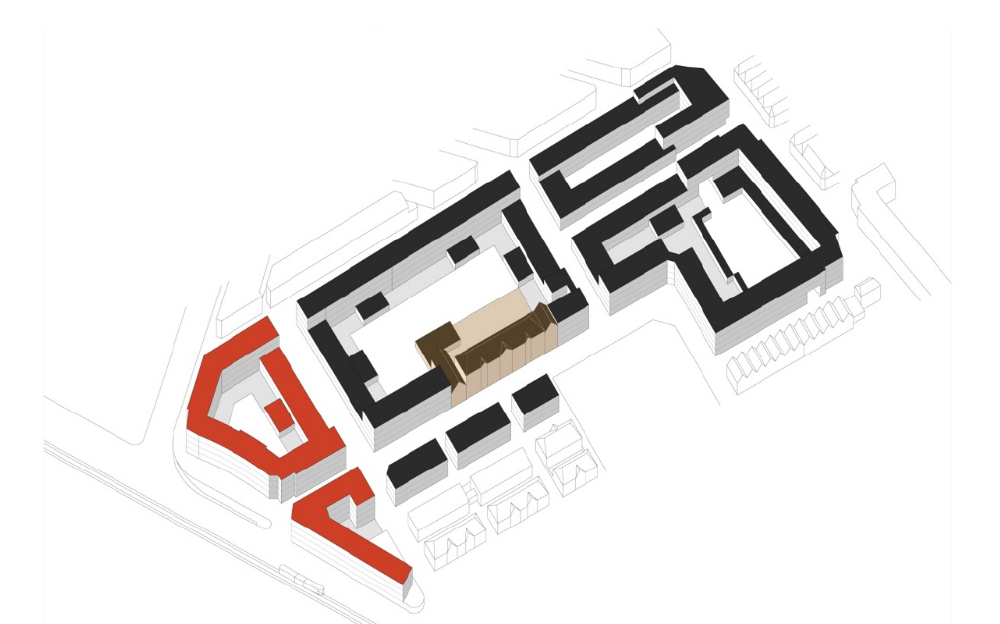
Figure 5. Deelgebied 5 (Schilderswijk, The Hague). The revised plan proposed in 1984 by Álvaro Siza. The school building that was to be preserved is highlighted in brown and the Punt en Komma blocks are highlighted in red. Author’s